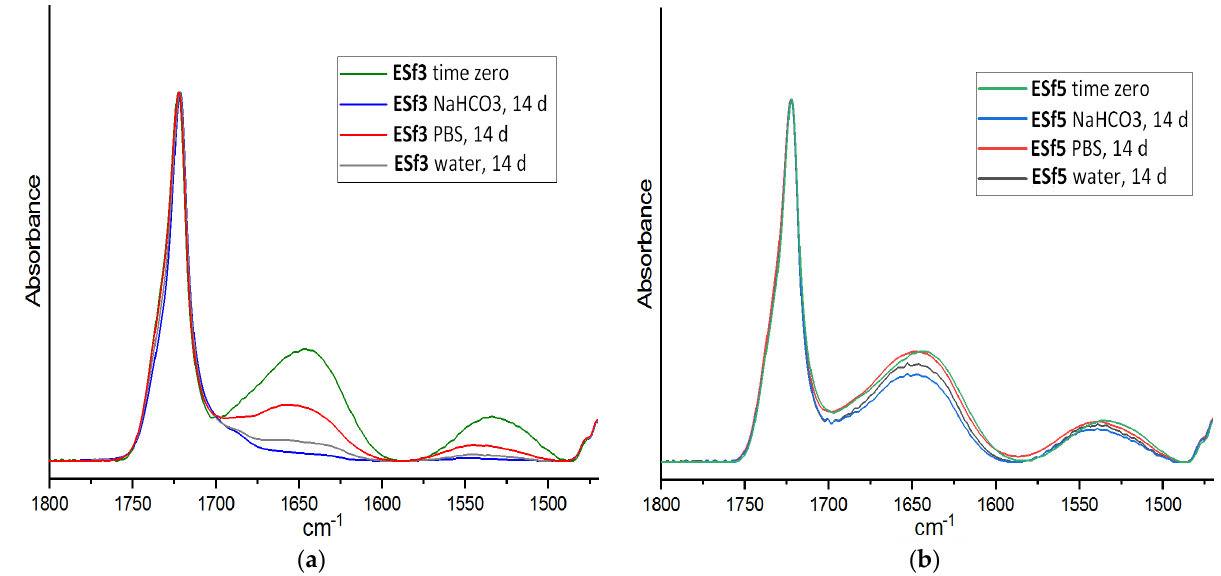
Figure 3. FT-IR spectra of the samples ESf3 ( a ) and ESf5 ( b ) before (green line) and after 14-day immersion in H 2 O, 0.1M NaHCO 3 , and 0.1M PBS (gray, blue, and red lines, respectively).